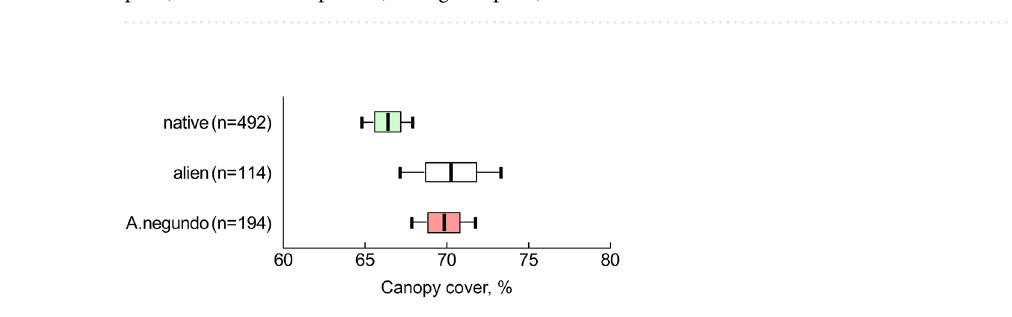
Figure 2. Average rates (± SE, ± 95CI) of canopy cover in communities dominated by Acer negundo (An+ ; pink plots) and other tree species (An− ; green plots).